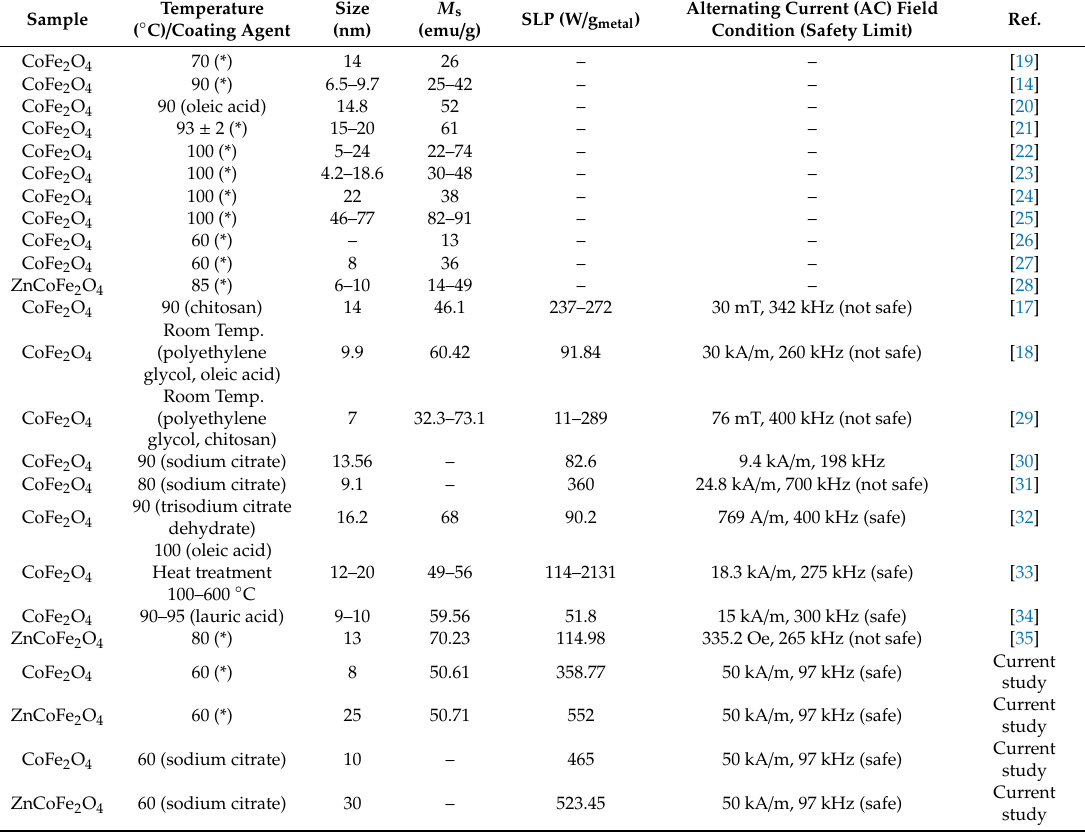
Table 2. Comparison between conventional co-precipitation methods and the current study.